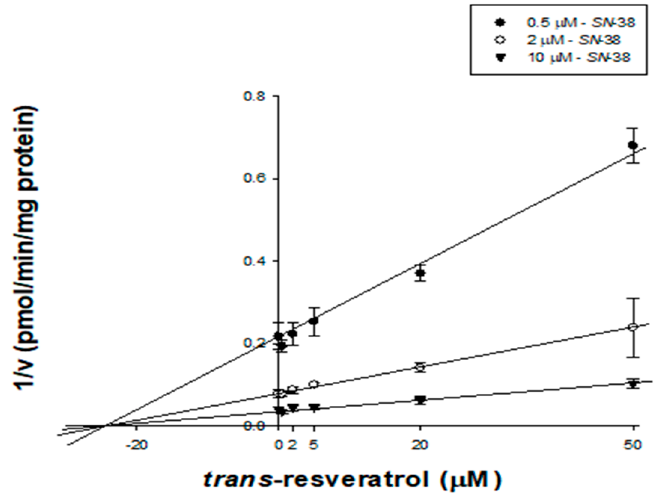
Figure 2. Representative Dixon plot obtained from an inhibition kinetic study of UGT1A1-mediated SN-38 glucuronidation in the presence of different concentrations of trans -resveratrol in pooled human liver microsomes ( n = 3). An increasing concentration of SN-38 (0.5 ( ), 2.0 ( ), and 10 μ M ( )) was incubated with HLMs (0.25 mg/mL) and UDPGA (1 h, 37 °C) in the presence or absence of trans -resveratrol (0, 0.5, 2.0, 5.0, 20, and 50 μ M).